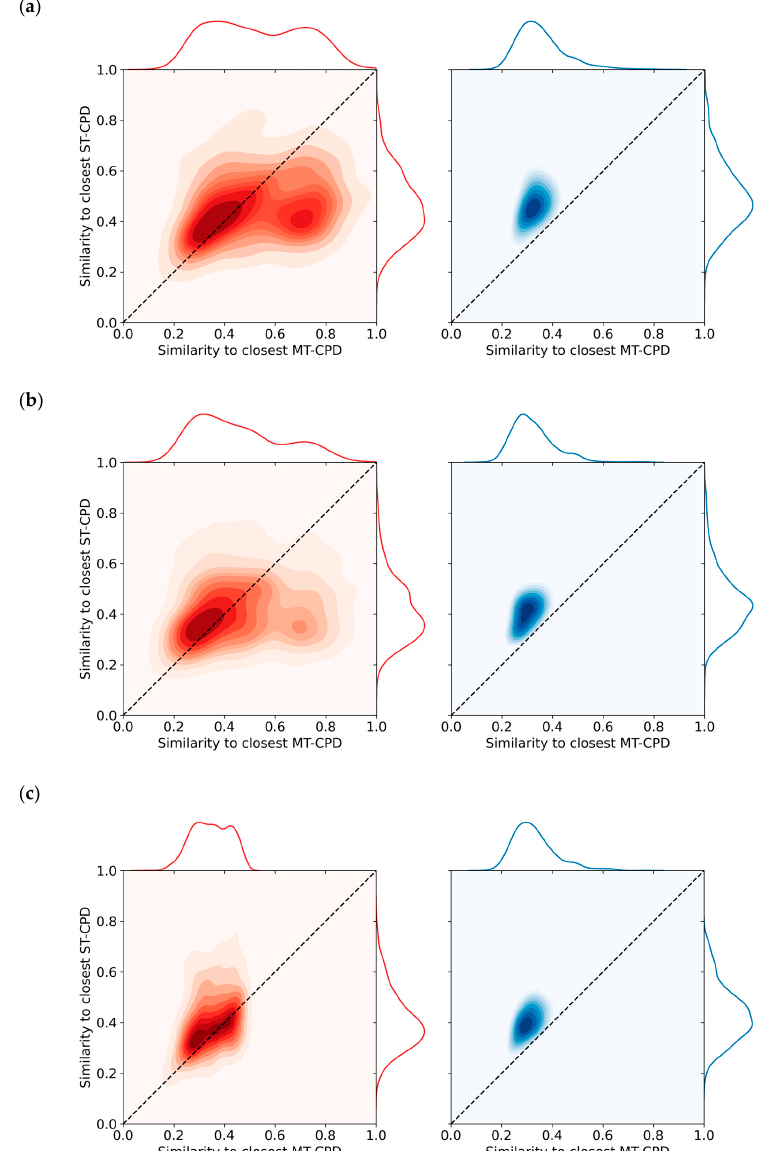
Figure 2. Nearest neighbor relationships for single- and multi-target compounds from biochemical assays. KDE plots report the distribution of closest similarity relationships. For each MT- and ST-CPD, all pairwise Tanimoto similarities were calculated. Similarity values for the NNs of all MT- (x-axis) and ST-CPDs (y-axis) are reported. The joint distribution is displayed as a KDE plot for MT-CPDs (red, left) and ST-CPDs (blue, right). In KDE plots, color intensity corresponds to di ff erent regions of data density, as delineated with contour lines. In addition, the underlying similarity value distributions are plotted on the top and right scale, respectively. Compounds falling onto the diagonal have the same closest similarity value to ST- and MT-CPDs. In ( a ), the similarity value distributions are reported for the original data set. In ( b ) and ( c ), NN calculations according to ( a ) were carried out after random removal of 50% of the MT- and ST-CPDs and removal of 50% of the NNs from MT- and ST-CPDs,